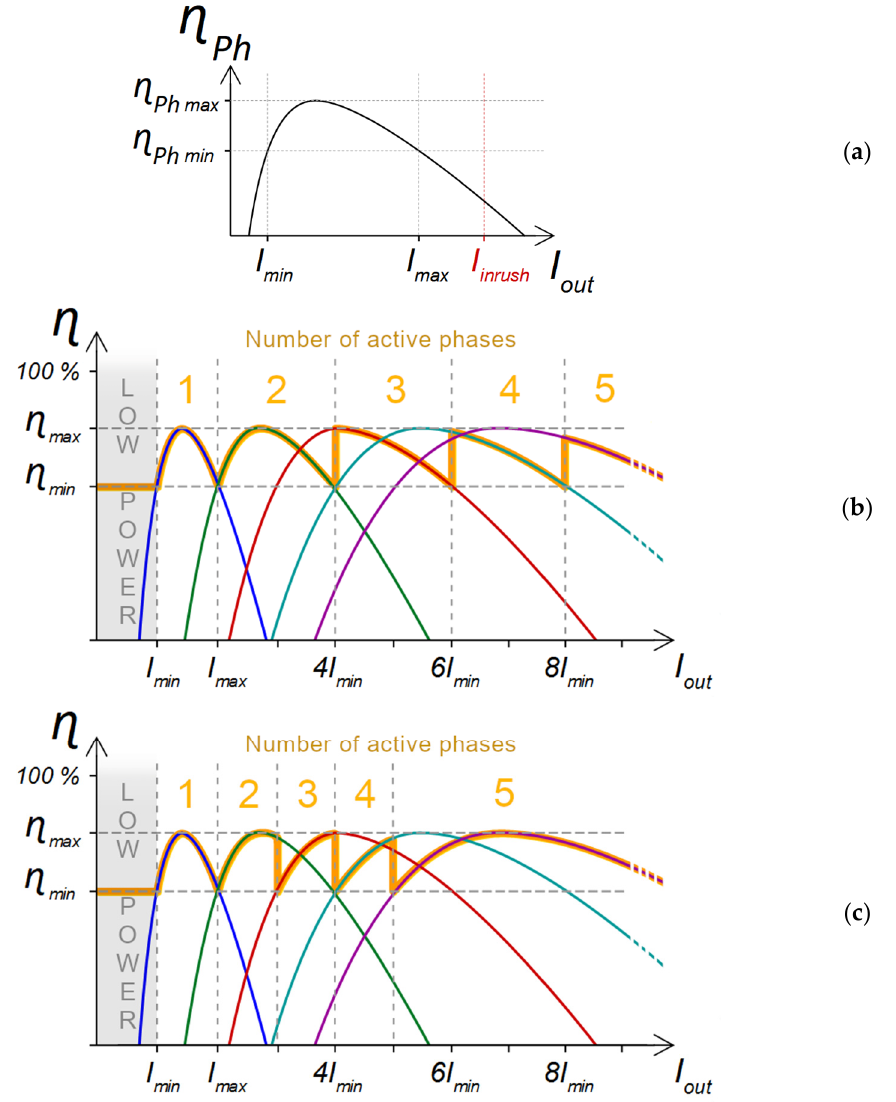
Figure 3. Decentralized phase-shedding strategy: ( a ) minimum, maximum and inrush current threshold levels considering the efficiency of one independent phase ɳ Ph vs. the output load current I out ; ( b ) behavior of the global efficiency ɳ during a load current increase; ( c ) behavior of the global efficiency ɳ during a load current decrease (with I max = 2 I min ). The independent efficiency responses of N -phase multiphase converters are shown with colored lines with N ranging from 1 to 5. The resulting converter efficiency, obtained using phase shedding, is shown in bright yellow.